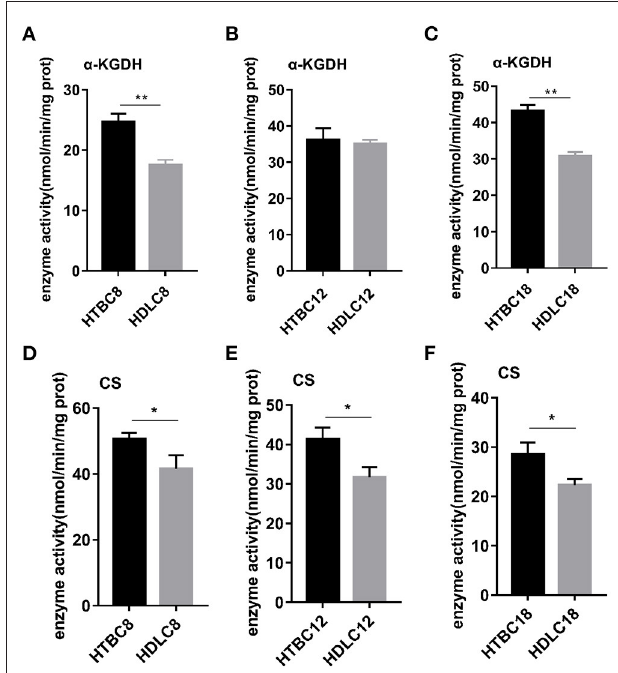
FIGURE 6 | The enzyme activity results under hypoxia at different developmental stages of chicken. (A–C) Enzyme activity of α -KGDH on days 8, 12, and 18 of incubation under hypoxia ( n = 3). (D–F) Enzyme activity of CS on days 8, 12, and 18 of incubation under hypoxia ( n = 3). HTBC, TBCs under hypoxia; HDLC, TBCs under hypoxia. Data are indicated as the mean ± SEM. Asterisks represent significance TBCs compared to DLCs. * P < 0.05, ** P <